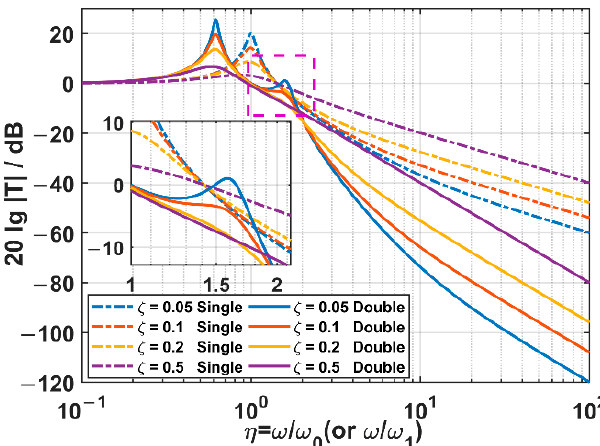
Figure 7. The acceleration transmissibility spectra of two suspension systems in different damping ratio cases. Among them, the dashed lines are the results of the OSSS, while the solid lines are those of the TSSS.